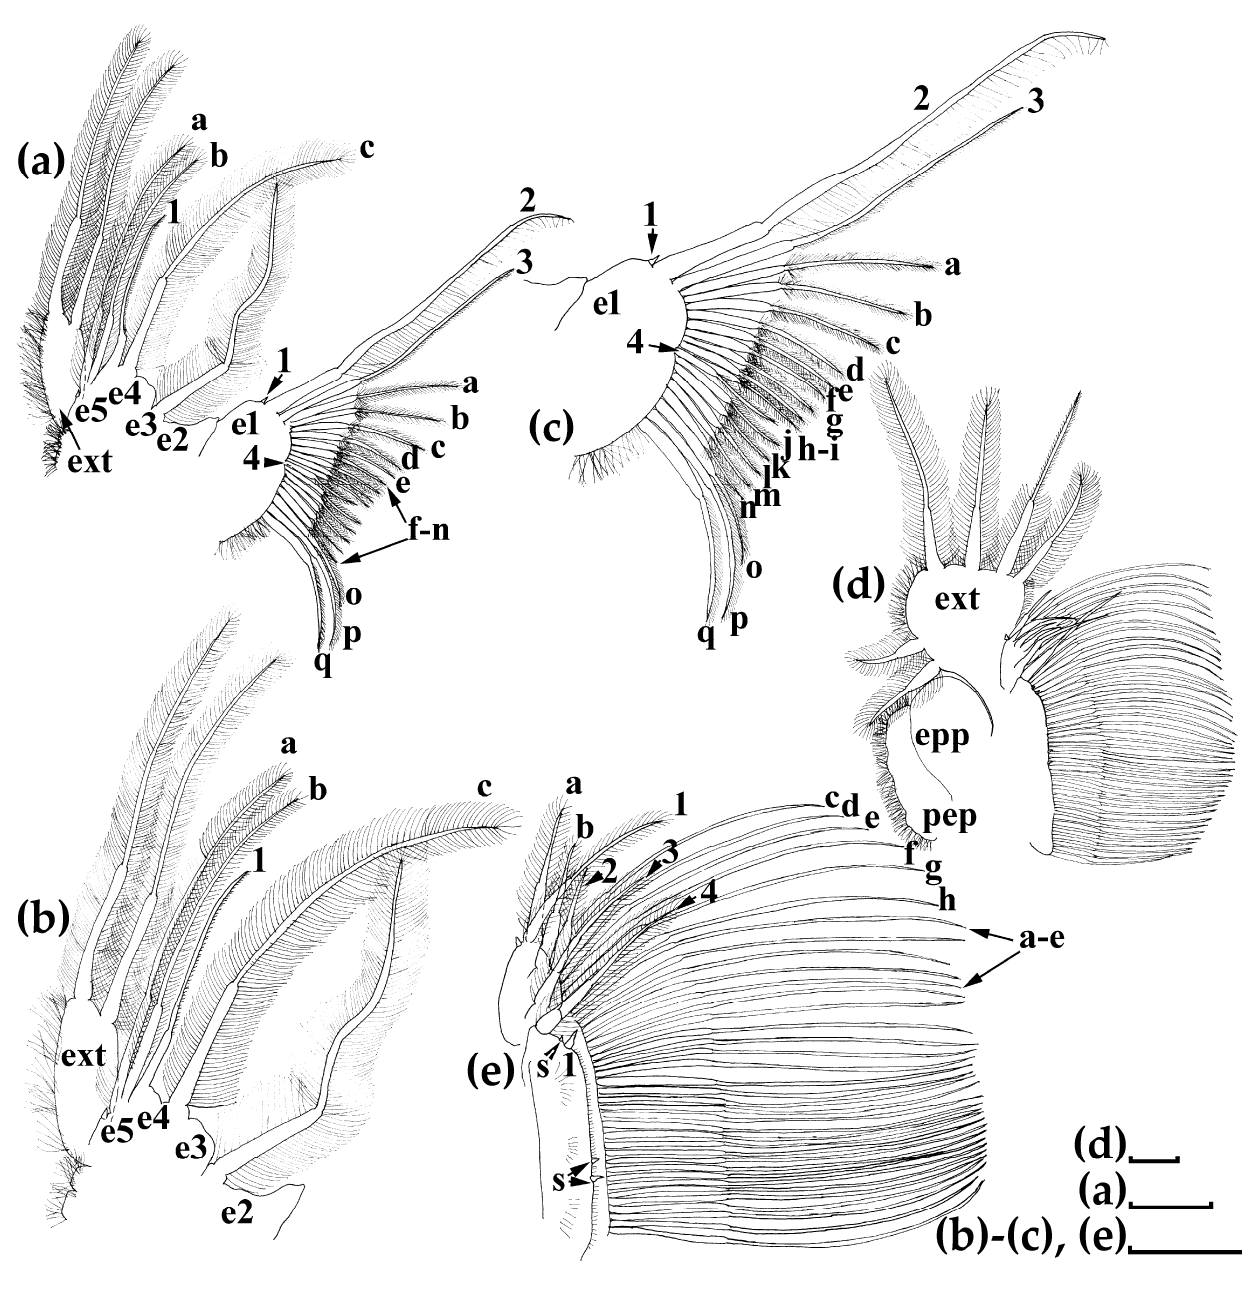
Figure 4. Daphnia arabica sp. nov., a parthenogenetic female from Al Shuwaib Dam, near Al Ain city, United Arab Emirates. ( a ) Thoracic limb II. ( b , c ) Fragments of thoracic limb II on higher magnification. ( d ) Thoracic limb III. ( e ) Gnathobase of thoracic limb III. All scale bars are 0.1 mm.